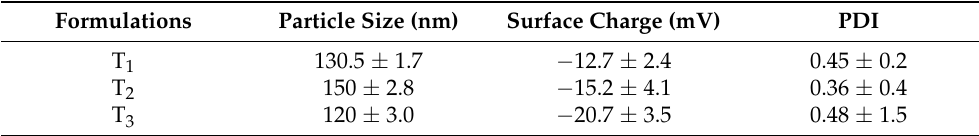
Table 2. Particle size, Surface Charge and Polydispersity index of the Capsaicin incorporated Nano-